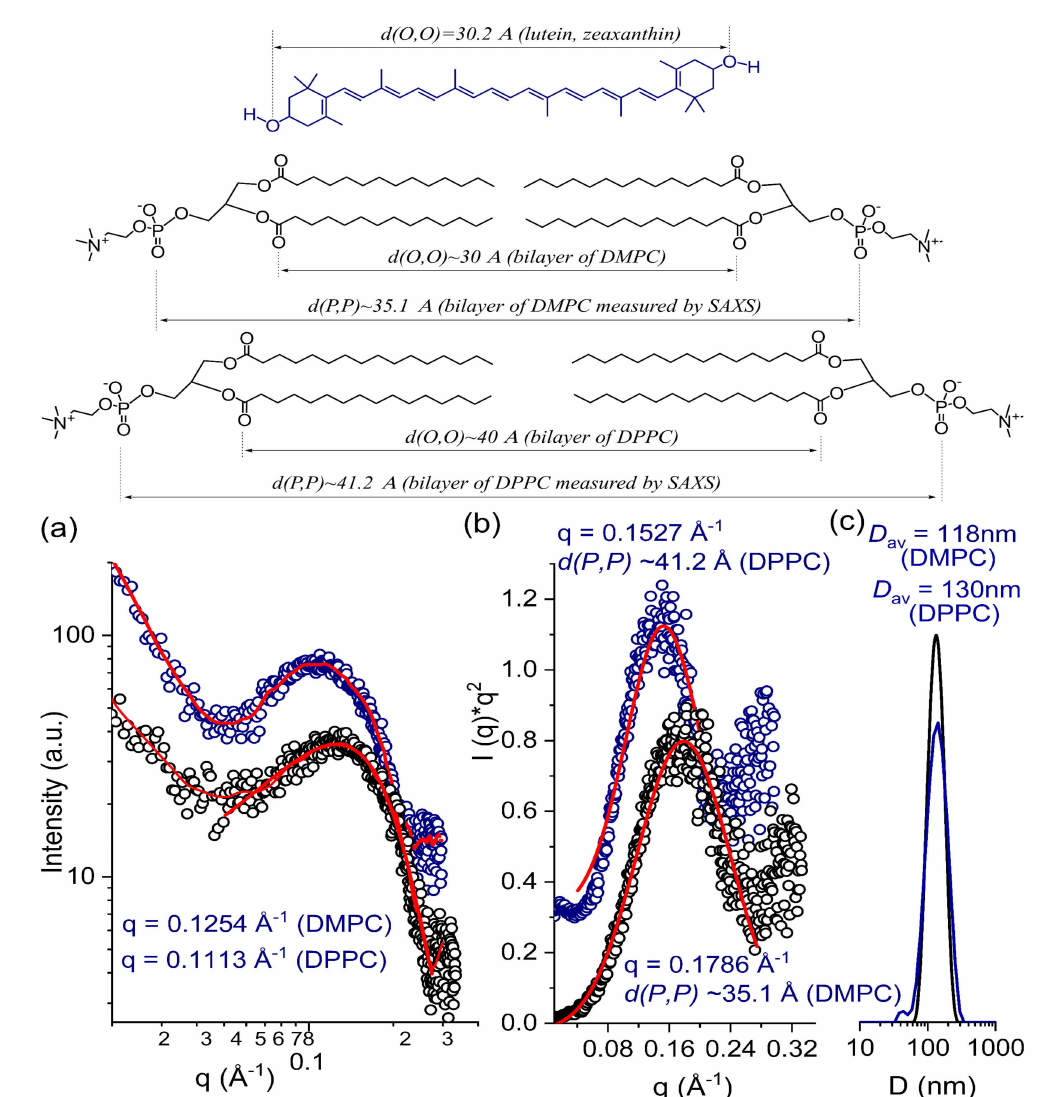
Figure 1. Top: Intramolecular dimensions of carotenoids and DMPC/DPPC bilayer as calculated by molecular mechanics [42,47]. The length of the carotenoid (lutein or zeaxanthin) corresponds to the length of the lipophilic seg- ment of the DMPC phospholipid (double the average distance between the carbonyl group and the methyl group of the DMPC), and does not match the length of the lipophilic segment of the DPPC. Bottom: ( a ) SAXS data of DMPC-zeaxanthin (black) and DPPC-zeaxanthin (blue) LUVs; ( b ) Kratky plot from SAXS data, supporting the formation of unilamellar LUVs; and ( c ) Size distribution and the average diameter of DMPC-zeaxanthin (black) and DPPC-zeaxanthin (blue) LUVs measured by DLS (Figure